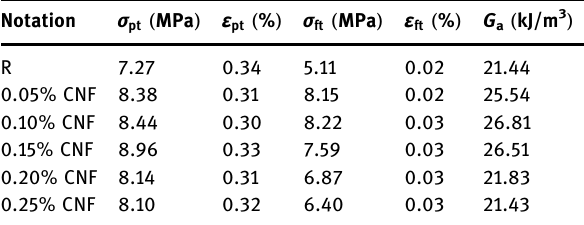
Table 4: Test results of specimens with various concentrations of CNF suspensions Notation